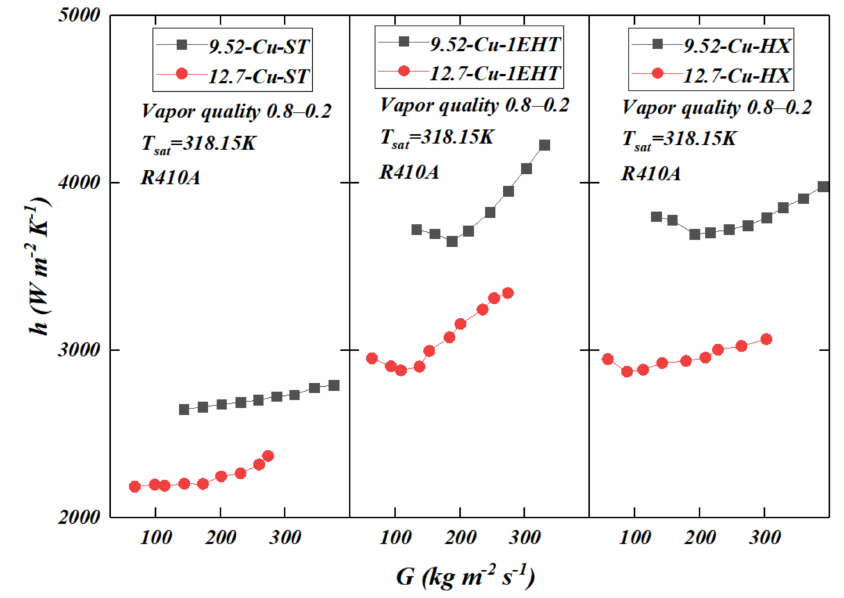
Figure 7. Variation of condensation heat transfer coefficients ( h ) inside copper tubes (different outer diameters) with mass flow rate ( G